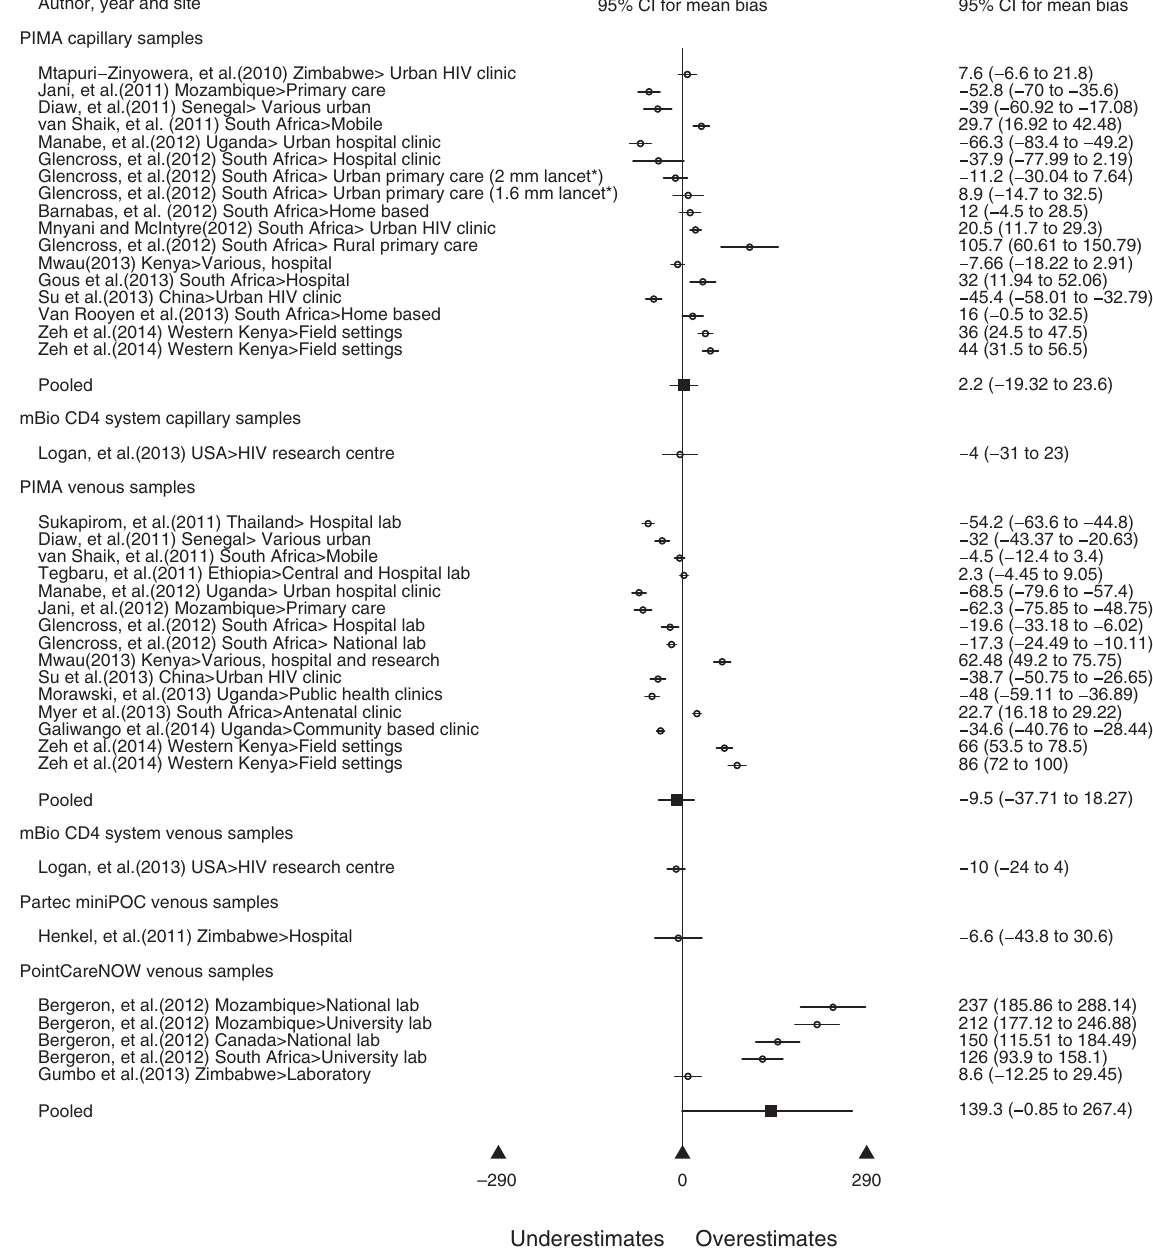
Figure 3. Bland – Altman results. Forest plot and pooled results, grouped by substrate used and POC